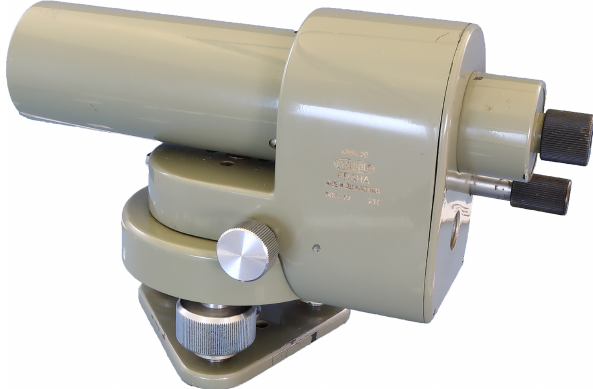
Figure 8. Levelling instrument MNK20 by Meopta company (photo supplied by https://www.surveyinginstruments.org).